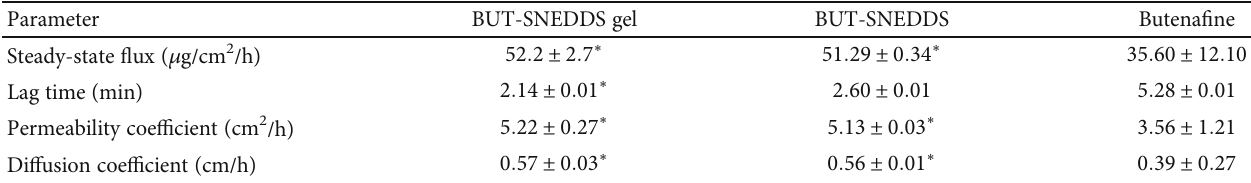
Table 2: Permeation parameters for butena fi ne and butena fi ne nanoenabled formulations across Strat membrane.